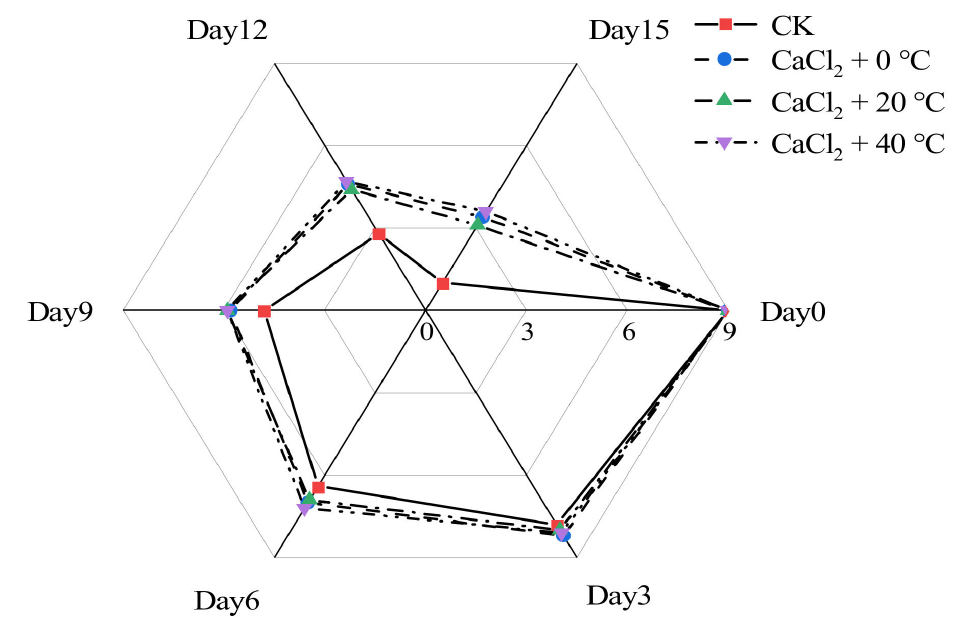
Figure 1. Sensory evaluation of fresh-cut “Xuebai” cauliflower florets given different treatments during